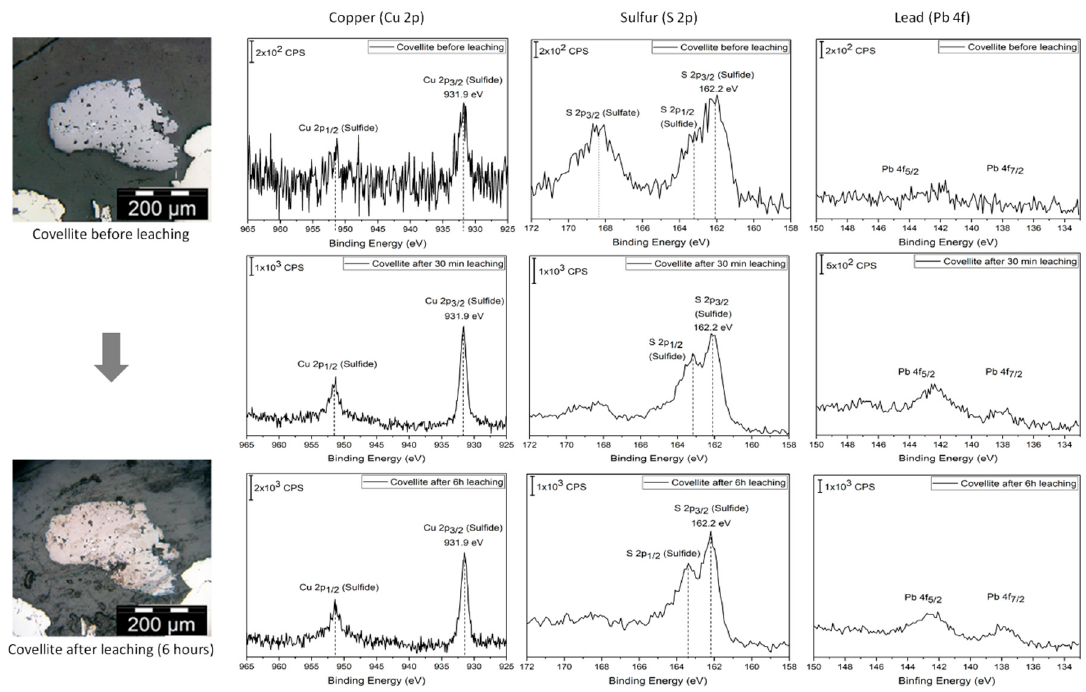
Figure 3. Changes observed during cyanidation of covellite. The top panels represent the initial results of characterization with polarization microscopy (left) and XPS signals for copper, sulfur and lead (from left to right). Identification of copper and sulfur species goes beyond the goal of this work, and they are reported collectively as “sulfide”. The middle panels correspond to XPS signals after the first 30 min of leaching and the bottom panels show the state of the pyrite grain investigated with PM and XPS after six-hour leaching. In this case there is no evidence of lead re-adsorption.